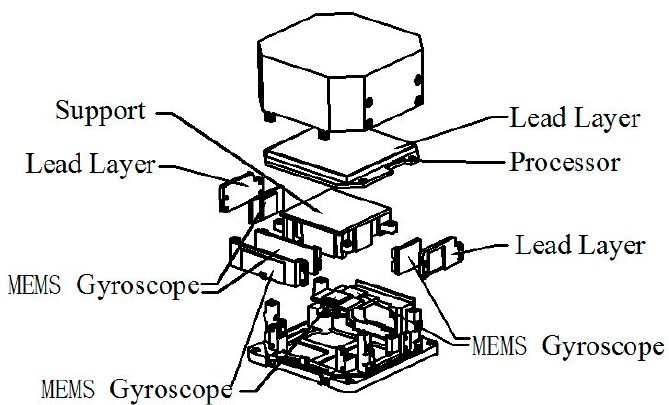
Figure 2. The structure diagram of the six-axis inertial measurement unit